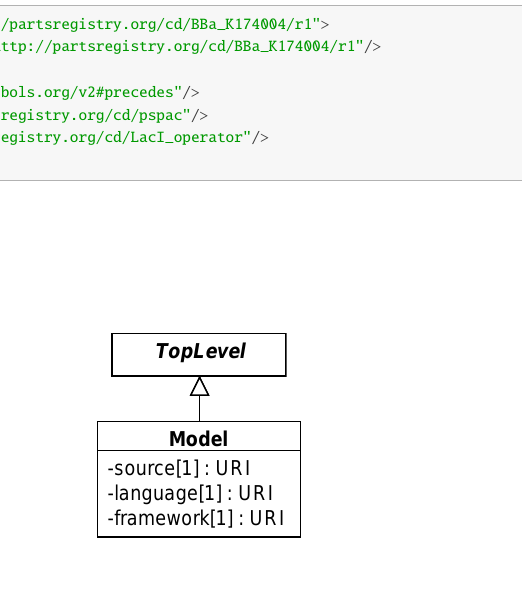
Figure 14: Diagram of the Model class and its associated